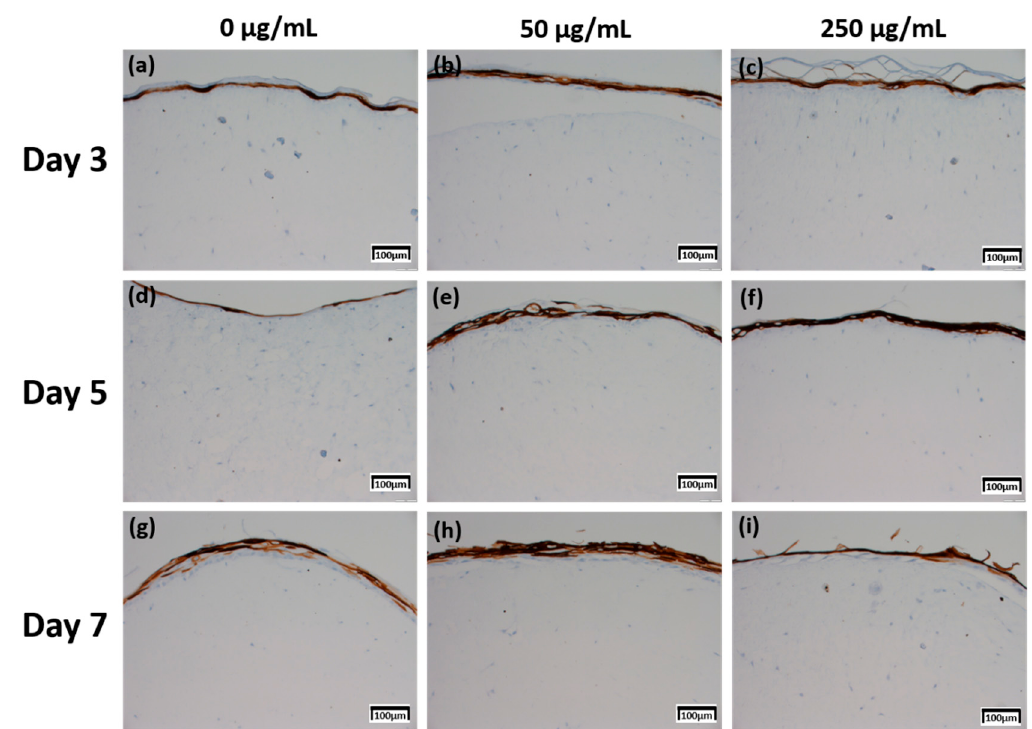
Figure 7. Immunohistochemistry stained images for keratin 10 of 3D cell cultured sample for 3 days air exposure using culture media-treated CLLE concentrations of ( a ) 0 μ g/mL, ( b ) 50 μ g/mL, and (c) 250 μ g/mL; for 5 days air exposure using culture media-treated CLLE concentrations of ( d ) 0 μ g/mL, ( e ) 50 μ g/mL, and ( f ) 250 μ g/mL; and for 7 days air exposure using culture media-treated CLLE concentrations of ( g ) 0 μ g/mL, ( h ) 50 μ g/mL, and ( i ) 250 μ g/mL.